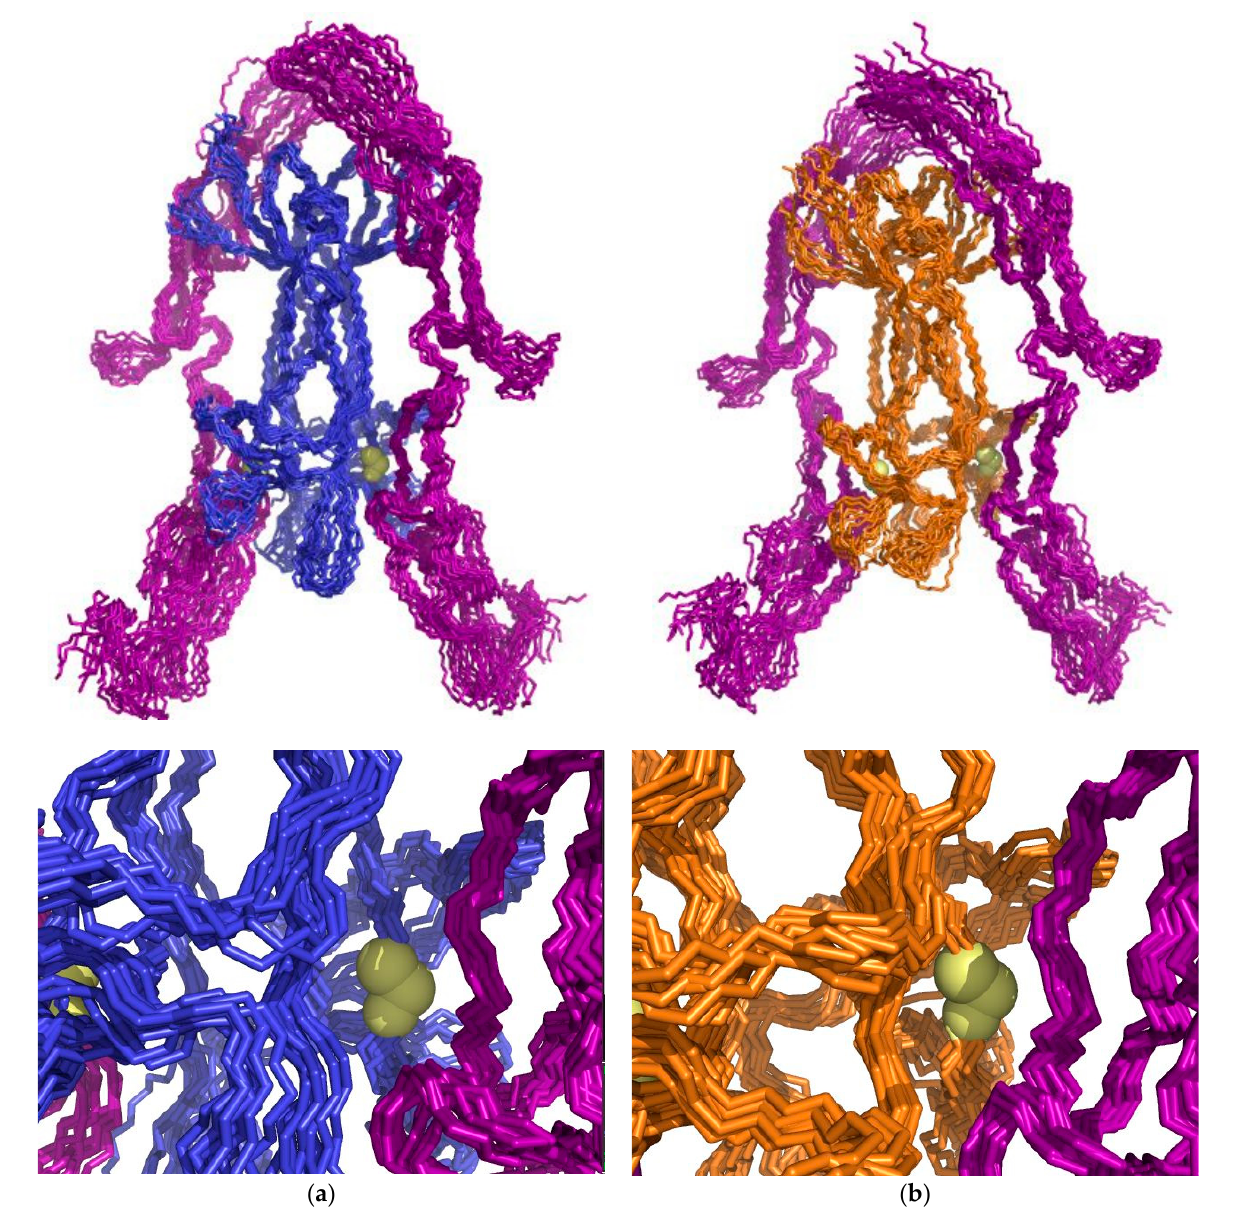
Figure 13. The structural ensembles generated by MD simulations for the complexes of p75NTR (in purple) with ( a ) proNGF WT (in blue) and ( b ) NGF R100W (in orange). The bundle of 10 most populated poses along the 100 ns simulation window for the overall complexes ( upper panel) and the detail of the contact surface involving position 100 with the chain Y of p75NTR ( lower panel), whose backbone atoms are highlighted by yellow spheres, are shown. Figure produced by Pymol (Schrödinger LLC 2010).